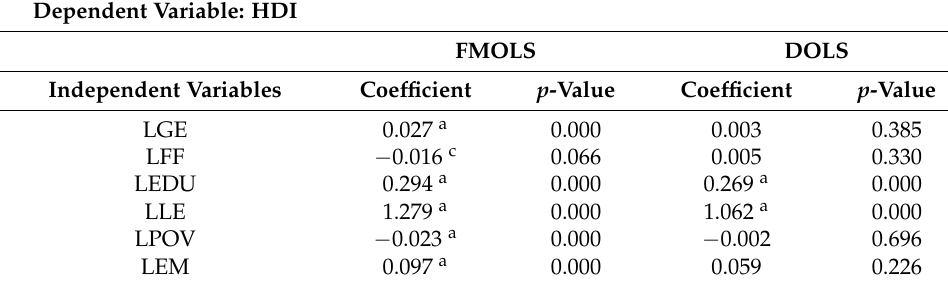
Table 7. Long-run